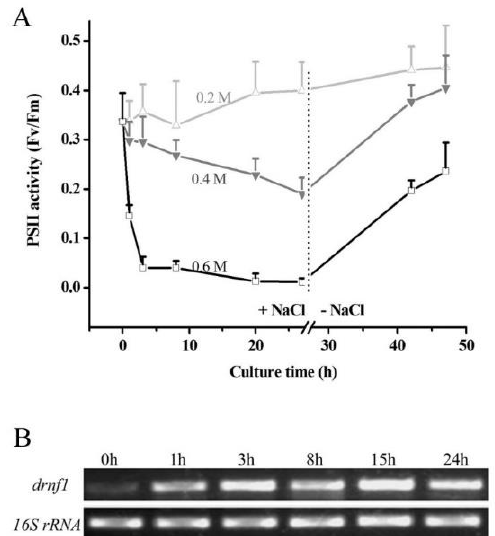
Figure 1. Salt stress response of Nostoc flagelliforme and induction of drnf1 transcription. ( A ) Physiologically recovered samples were treated by NaCl solutions for 27 h and then transferred to normal solutions for physiological recovery for 20 h. Physiological changes were indexed with the Fv/Fm parameter. Data are mean ± s.d. ( n = 5); ( B ) Semi-quantitative RT-PCR analysis of transcription levels of drnf1 gene under 0.4 M NaCl for different times. 16S rRNA gene was used an internal reference.